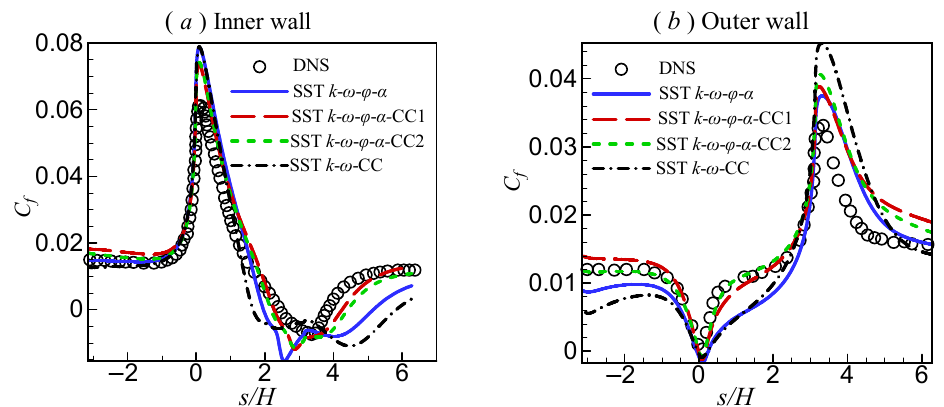
Figure 4. Comparison of friction coefficient distribution along the inner ( a ) and outer ( b ) walls.